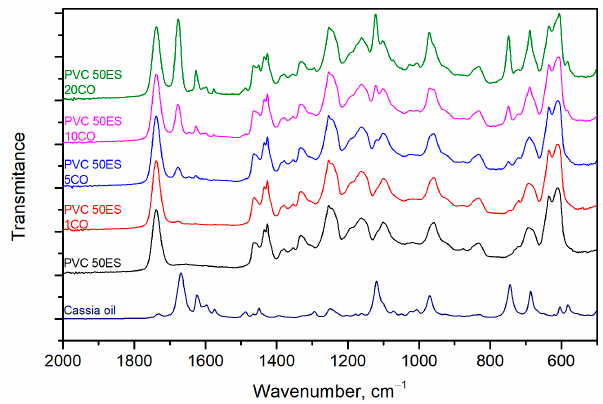
Figure 7. FTIR spectra of obtained materials in the wavenumber range 2000–500 cm − 1 . In the wavelength range analysed, a peak at around 1430 cm − 1 (C-H bonds in the PVC chain), a peak at 1252 cm − 1 (bending vibrations of the C–H originating from CHCl), and the bands at 1099 cm − 1 and around 680 cm − 1 (as a result of the presence of C–C and C–Cl groups) were observed [56].